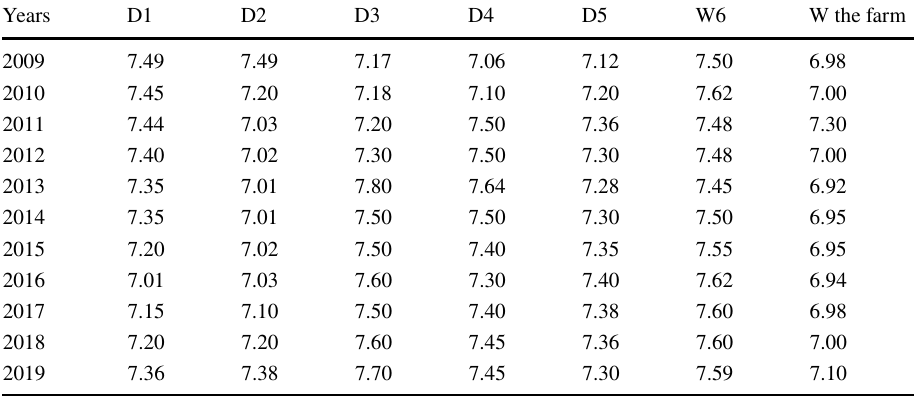
Table 3 pH values of water points in the Mougheul area